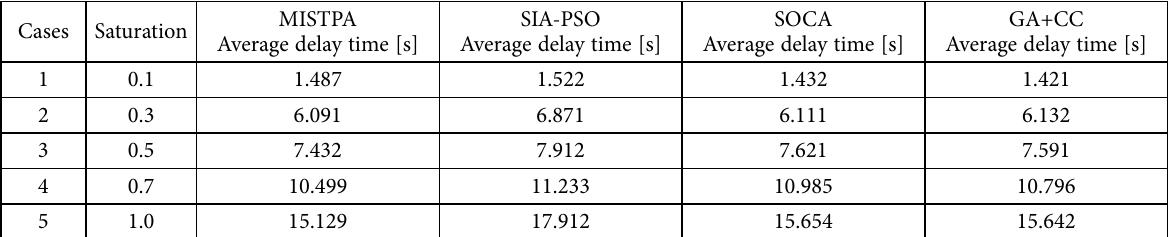
Table 6. Simulation data and comparison with other state-of-the-art algorithms MISTPA Cases Saturation Average delay time